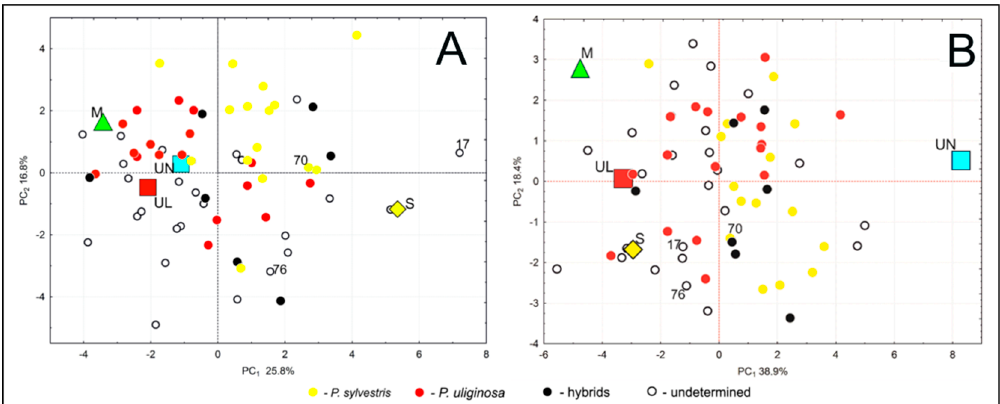
Figure 6. Principal component analysis PCA plot showing relationships between individuals from four groups defined at the mixed pine population in B łę dne Ska ł y (marked in circles) and reference species, including P. sylvestris (S), P. mugo (M), P. uliginosa (UL) and P. uncinata (UN); (numbers 17, 70 and 76 indicate individuals with cpDNA haplotype characteristic for P. sylvestris ): (A) based on needle traits; (B) based on cone traits.